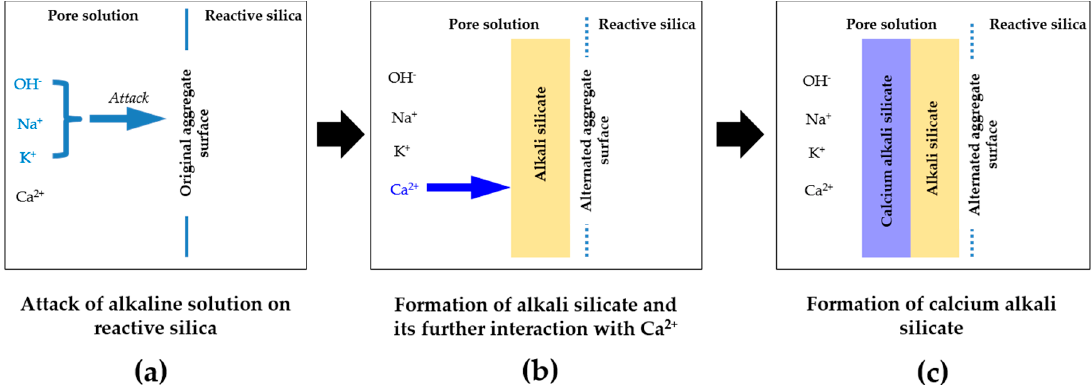
Figure 4. Schematic representation of the interaction of reactive silica with the constituents in the pore solution of cement paste: ( a ) attack of alkaline solution on reactive silica; ( b ) formation of alkali silicate and its further interaction with Ca 2+ ; ( c ) formation of calcium alkali silicate.